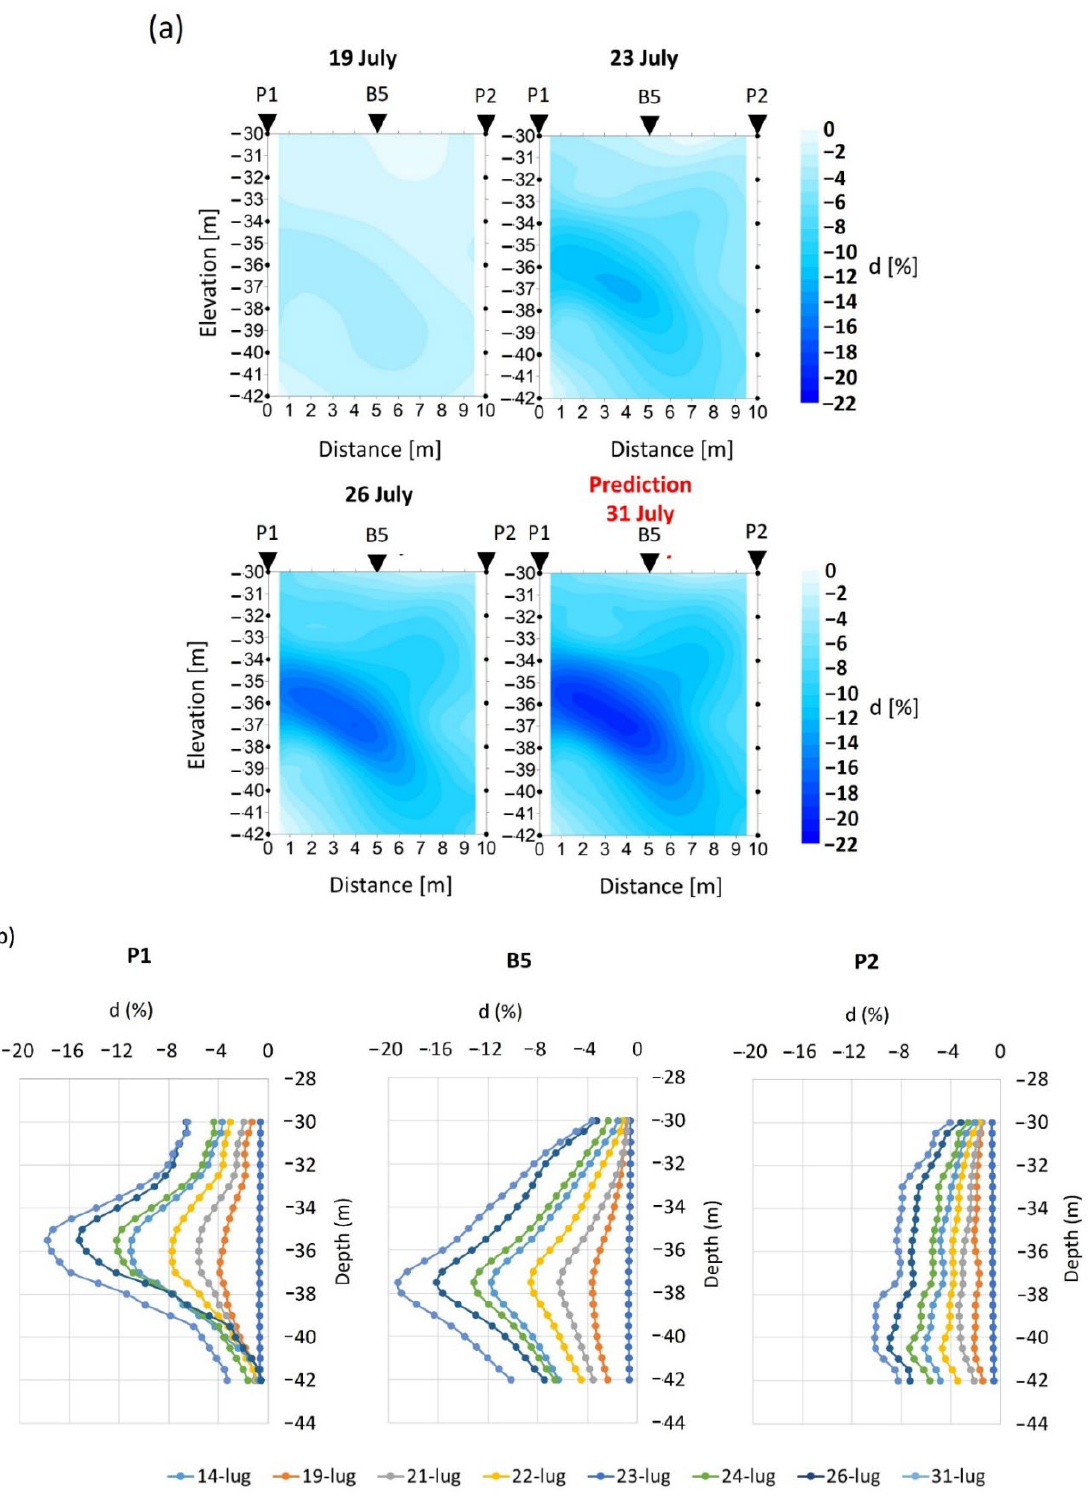
Figure 8. ( a ) Some images of resistivity variation (d, %) after tracer injection. Black dots are electrodes, and P1, P2, and B5 are piezometers; ( b ) electrical resistivity variation (d, %) curves along the piezometers P1, B5, and P2 from the CH-ERT dataset. Values at days 29 and 31 were estimated from CH-ERT predicted datasets.